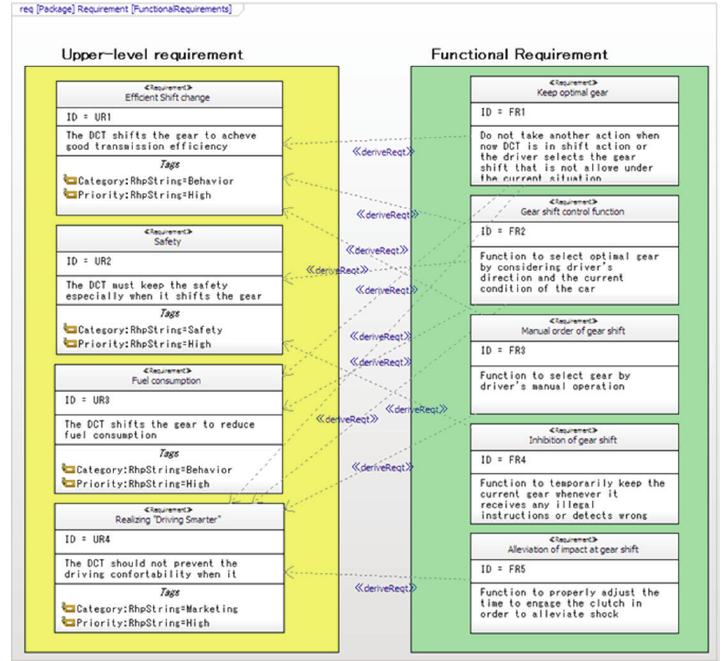
Figure 9: Functional requirements.